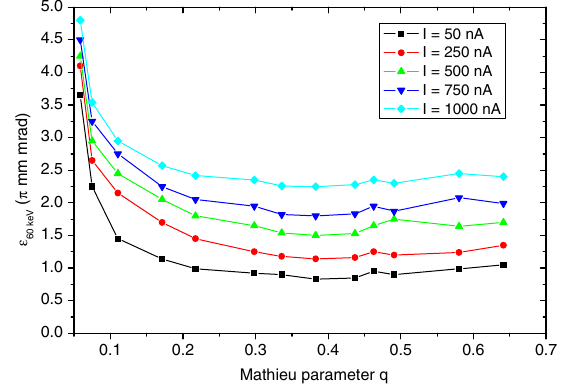
FIG. 10. Measurements of geometric transverse emittances versus Mathieu parameter q (i.e., rf voltage) for various beam currents.